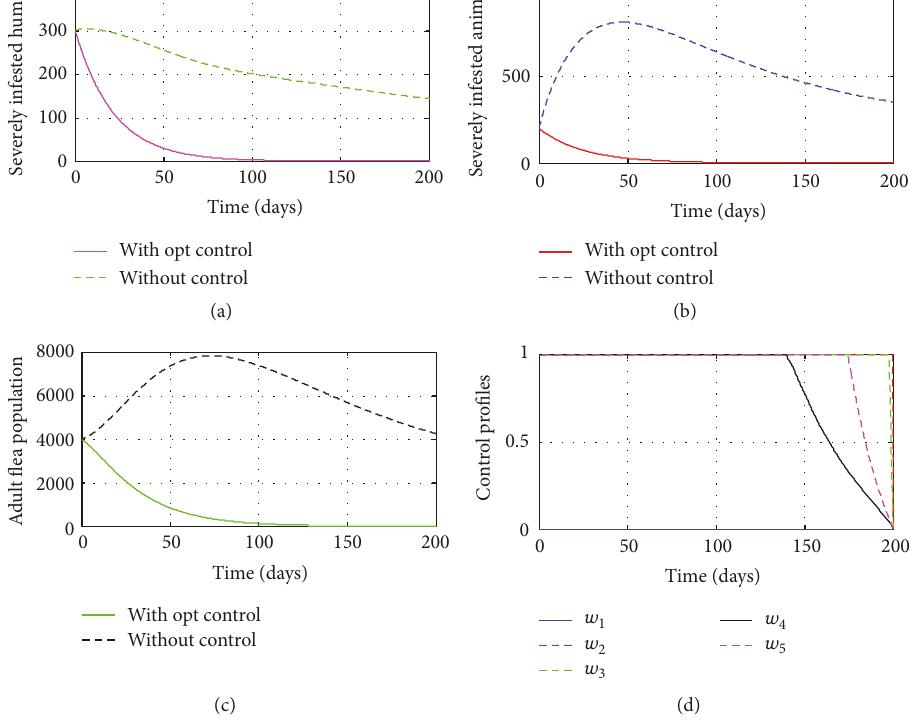
Figure 4: Optimal solutions for model variables 𝐼 𝐻ℎ , 𝐼 𝐴ℎ , 𝐹 𝐸 and the control profiles for 𝑤 1 , 𝑤 2 , 𝑤 3 , 𝑤 4 , 𝑤 5 with (𝑤 2 , 𝑤 3 , 𝑤 4 ,𝑤 5 ̸= 0)